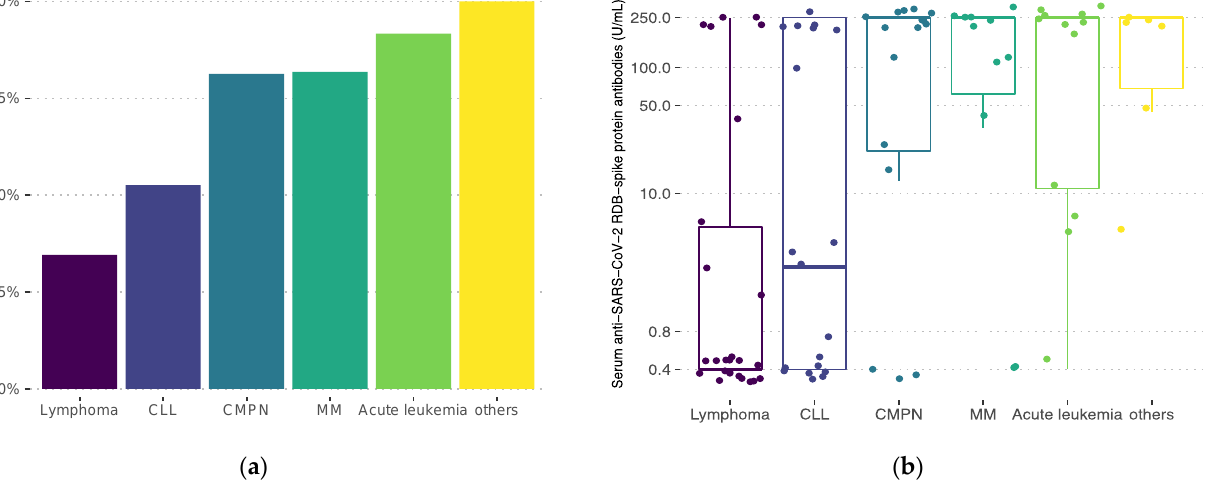
Figure 1. Seropositivity rates ( a ) and anti-SARS-CoV-2 spike protein receptor-binding domain antibody titers ( b ) after two vaccine doses according to diagnosis: lymphoma (Hodgkin’s or non-Hodgkin’s lymphoma; n = 26), chronic lymphocytic leukemia (CLL; n = 19), chronic myeloproliferative neoplasms (CMPN; chronic myeloid leukemia, polycythemia vera, myelofibrosis, chronic eosinophilic leukemia, n = 16), multiple myeloma/amyloidosis (MM; n = 11), acute leukemia ( n = 12), others (myelodysplastic syndrome, aplastic anemia, idiopathic thrombocytopenic purpura, n = 6). Overall p < 0.001. Positive results are defined as >0.8 U/mL.